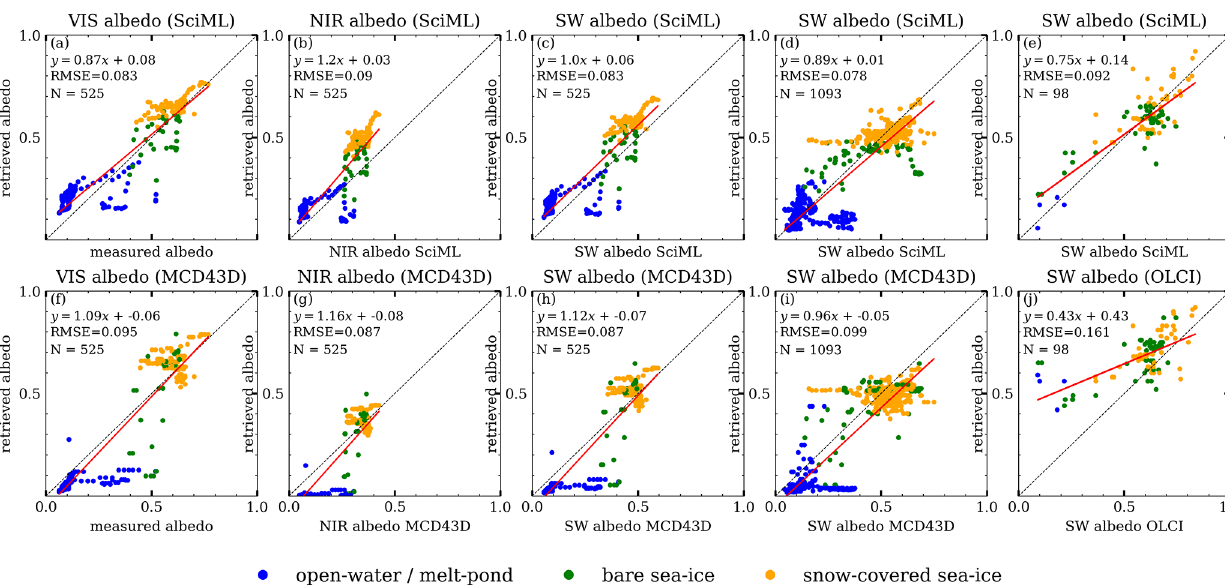
Figure 14. Correlation between satellite retrievals and ACLOUD albedo measurements utilizing three retrieval methods. (f–h) MCD43D albedo in the visible, near-infrared, and shortwave broadband compared to albedometer measurements; (i) MCD43D shortwave albedo compared to pyranometer measurements; and (j) comparison between the OLCI shortwave albedo derived with the MPD algorithm and all shortwave measurements from the ACLOUD campaign. (a–e) RTM–SciML retrievals that are regridded to the MCD43D or OLCI pixels. Surface type is represented by color. The regression relation between retrieval and measurements, RMSE, and the number of valid pixels are given in the upper left of each panel. Other statistical metrics ( R 2 , bias, f EE ≤ 15 , etc.) can be found in Table B3 in Appendix